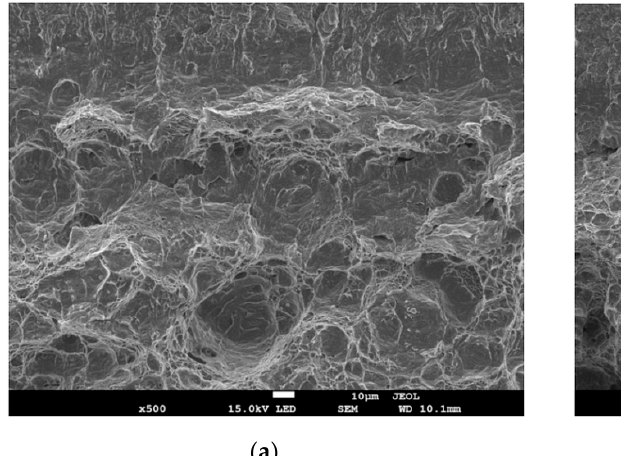
Figure 6. ( a ) The J C with test temperature dependence for specimens of different thicknesses; ( b ) the J C changes with specimens thickness for different test temperatures.